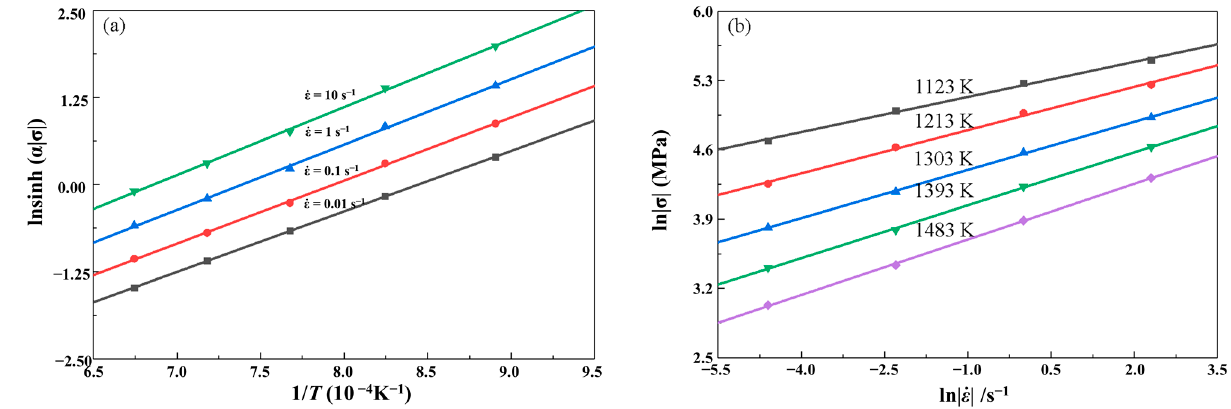
(cid:12) (cid:12) . ε